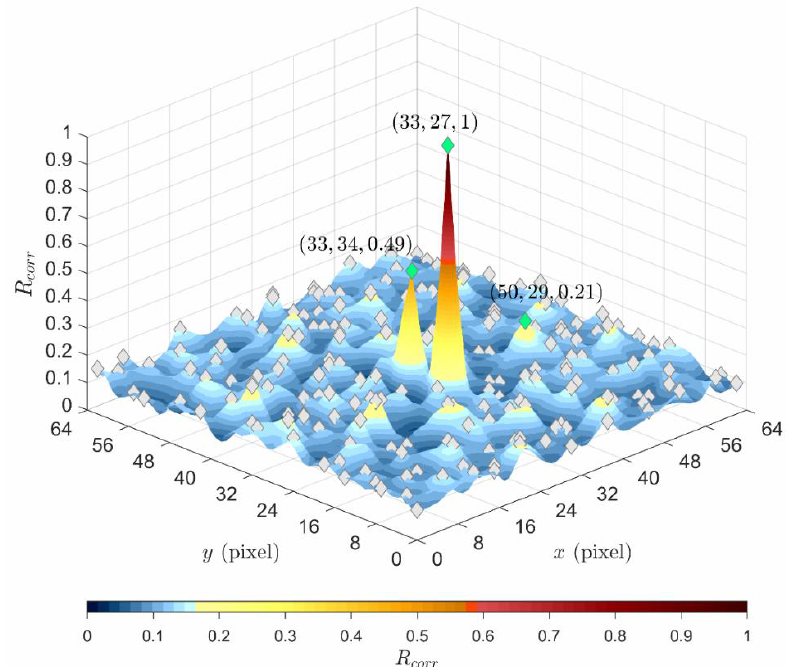
Figure 3. Diamond : Local peaks identified by the automatic peak finding scheme. Green diamond marks the peaks of the largest three R corr .